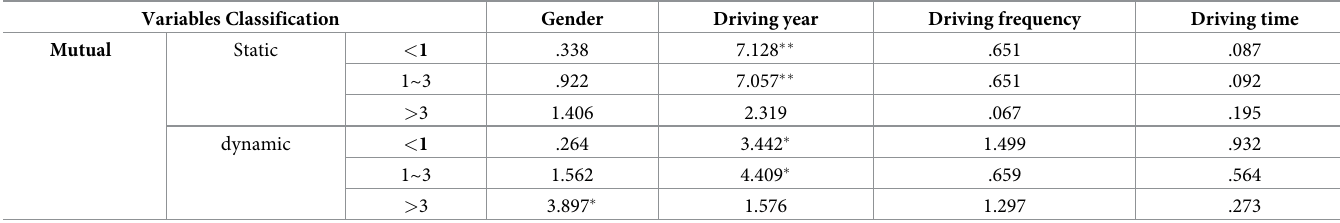
Table 5. One-way ANOVA between MAS and driver characteristics. Variables Classification